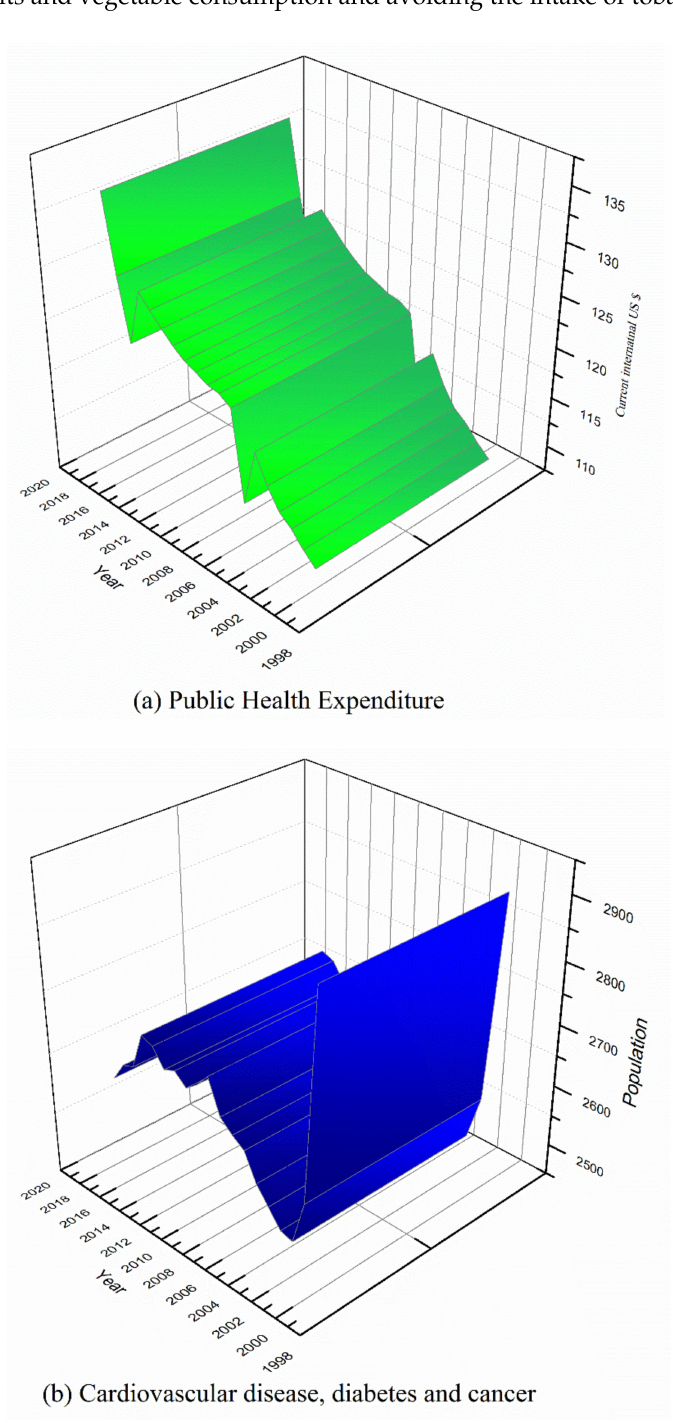
Figure 1. Health indicators ( a ) public health expenditure ( b ) cardiovascular disease, diabetes and